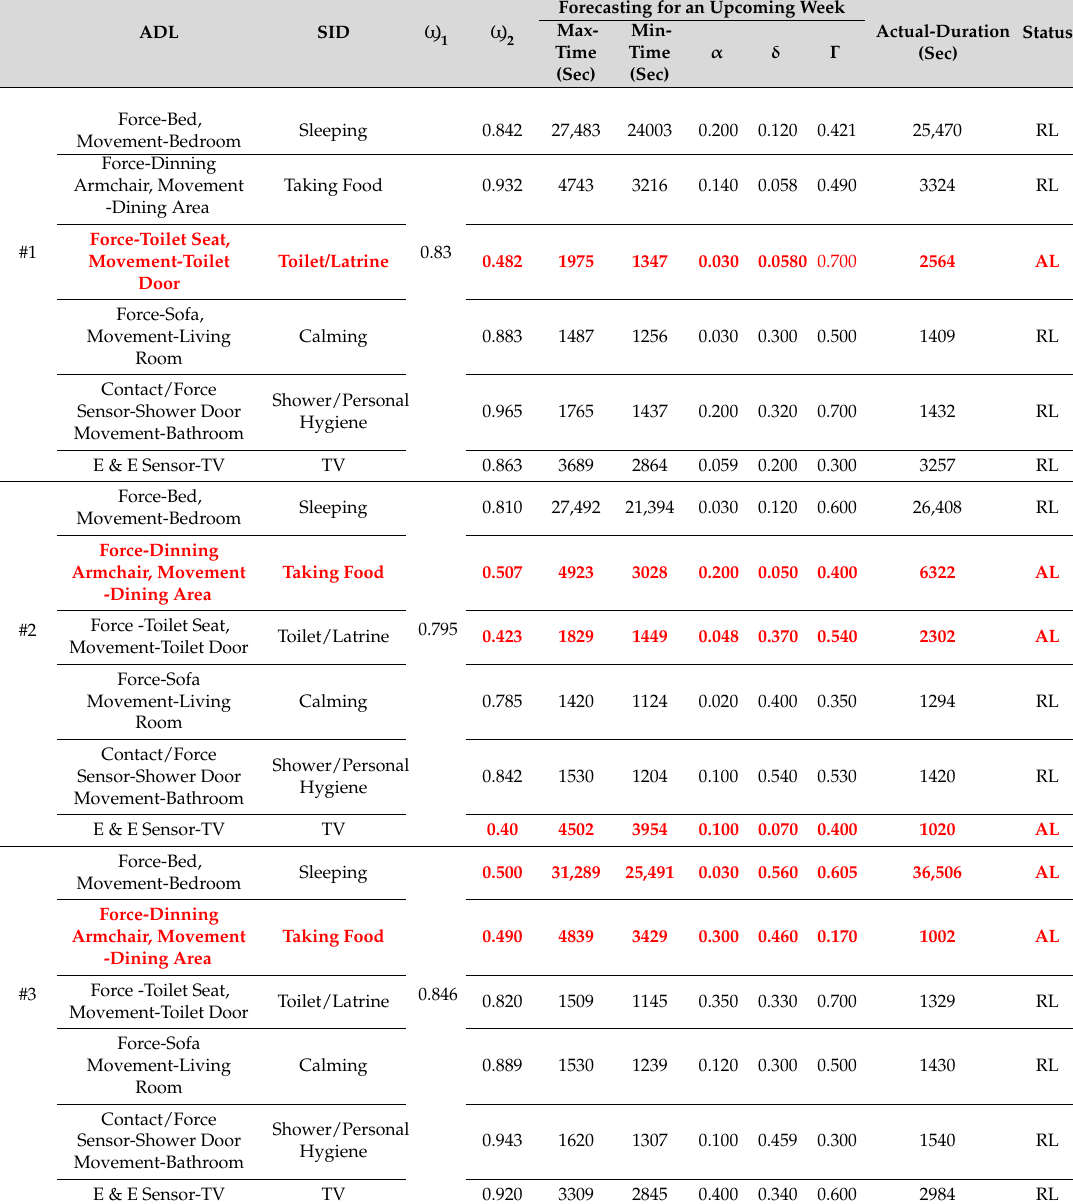
Table 4. Well-being detection and anomaly forecasting on the basis of Wellness parameters.